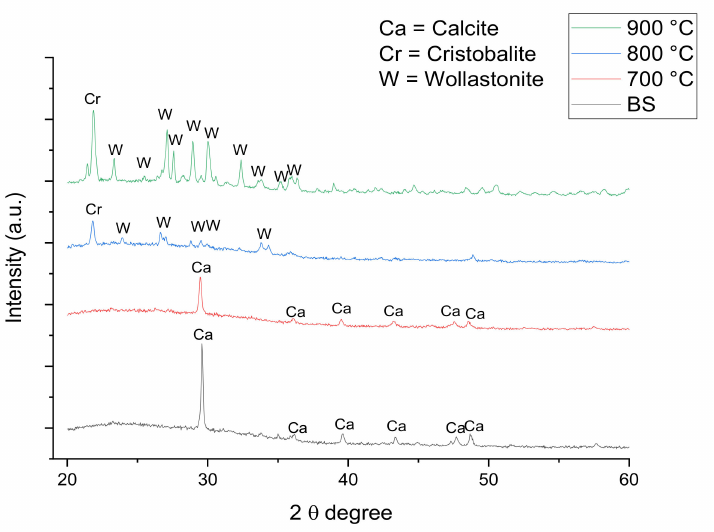
Figure 5. XRD pattern of foam glass-ceramics 6 wt% sintered at various temperatures for 60 min. The FTIR spectra of 1 and 6 wt% samples sintered at 800 ◦ C for 60 min are shown in Figures 6 and 7, respectively. The IR absorption band and foam glass-ceramics band assignment for 1 and 6 wt% samples at various temperatures can be seen in Table 3.